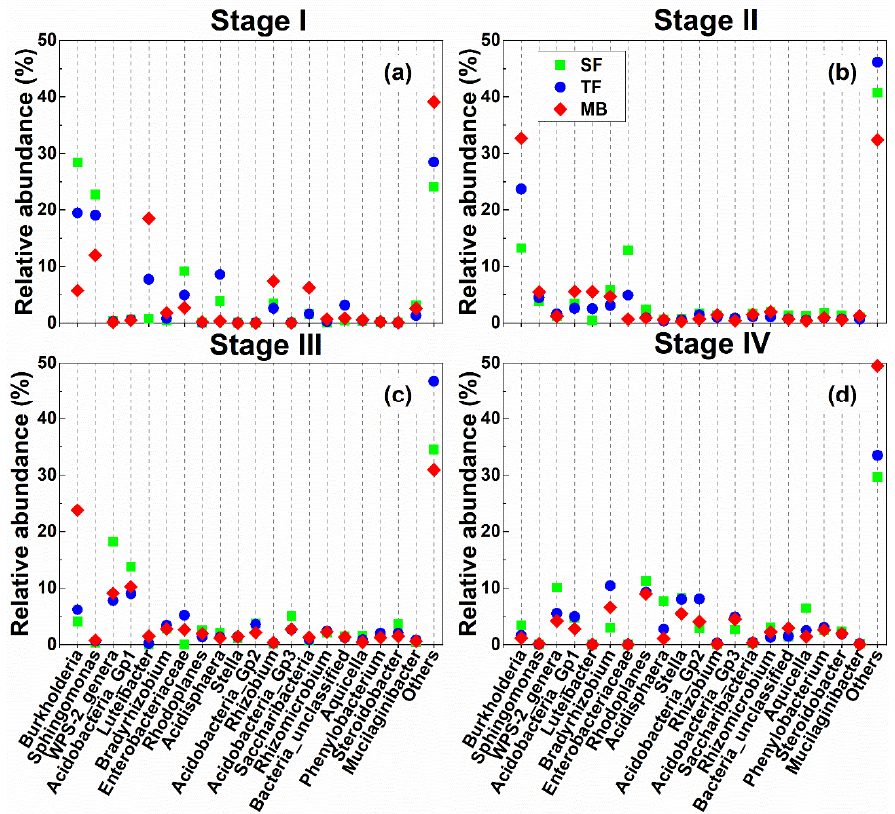
Figure 4. Relative abundances of bacterial OTU clusters at the genus level from the four litter decomposition stages (I, II, III, and IV) in the three forest types. ( a – d ) a–d, in turn, is the litter decomposition stages I, II, III, IV. The codes for forest types are described as in Figure 1. The data shown are the 20 taxa with the highest abundances, as well as the summed abundance of the remaining taxa (labeled as